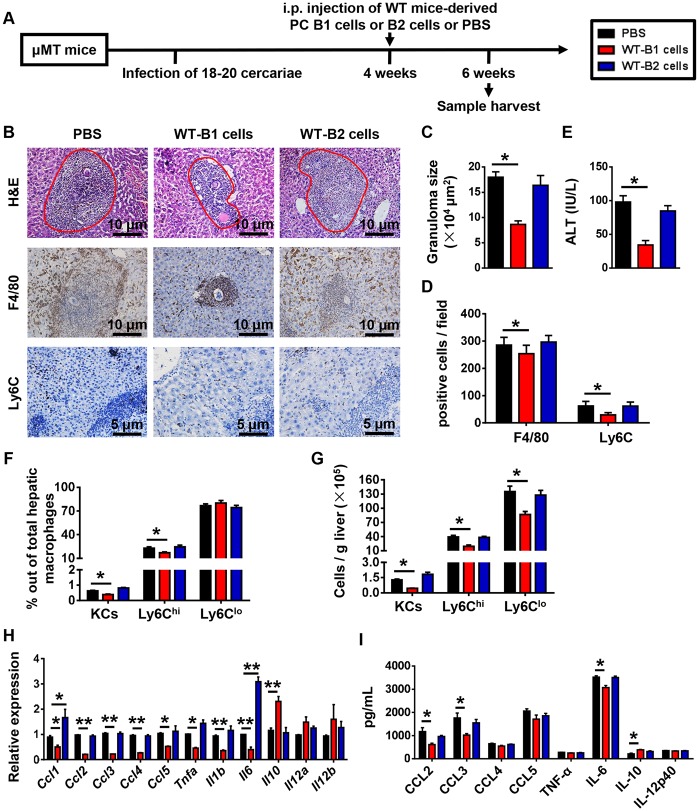
Adoptive transfer of B1 cells attenuates S. japonicum-induced liver pathology in μMT mice.(A) Schematic representation of the model of mice treatment. The μMT mice were infected with 18–20 cercariae of S. japonicum. FACS-sorted PC B1 cells (2 × 106 cells) or B2 cells (2 × 106 cells) from uninfected WT mice were adoptive transferred into μMT mice 4 weeks after infection. Mice were sacrificed 6 weeks after infection. (B) Representative images of H&E, F4/80, and Ly6C stained liver tissues. Original magnification, × 200 for F4/80, × 400 for Ly6C. (C-E) Statistical analysis of hepatic granuloma sizes (C), numbers of F4/80- and Ly6C-positive cells per field (D), and serum ALT levels (E). (F) Graphical summary showing percentages of indicated cell subsets out of total hepatic macrophages in infected μMT mice after cell transfer assayed by flow cytometry. (G) Numbers of indicated cell subsets in the liver of infected μMT mice after cell transfer analyzed by flow cytometry. (H) Quantitative PCR analysis of chemokine and inflammatory cytokine gene expression levels in the liver. (I) Hepatic chemokine and inflammatory cytokine protein expression levels were examined by CBA and ELISA. Data represent mean ± SD; n = 5–7 per group from two independent experiments. *p < 0.05, **p < 0.01.